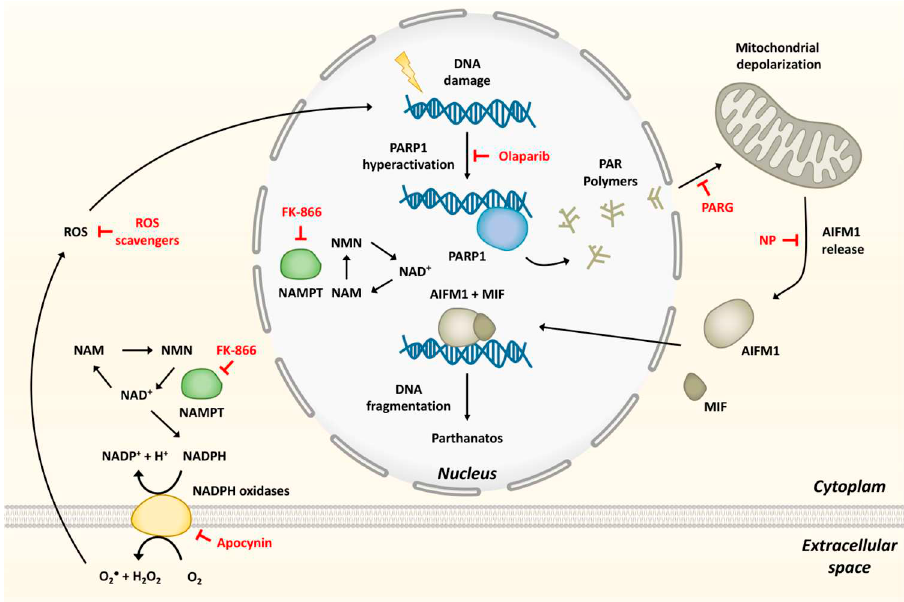
MIF, migration inhibitory factor; NAD+, nicotinamide adenine dinucleotide; NAM, nicotinamide; NAMPT, nicotinamide phosphoribosyltransferase; NMN, nicotinamide mononucleotide; NP, N-phenylmaleimide;